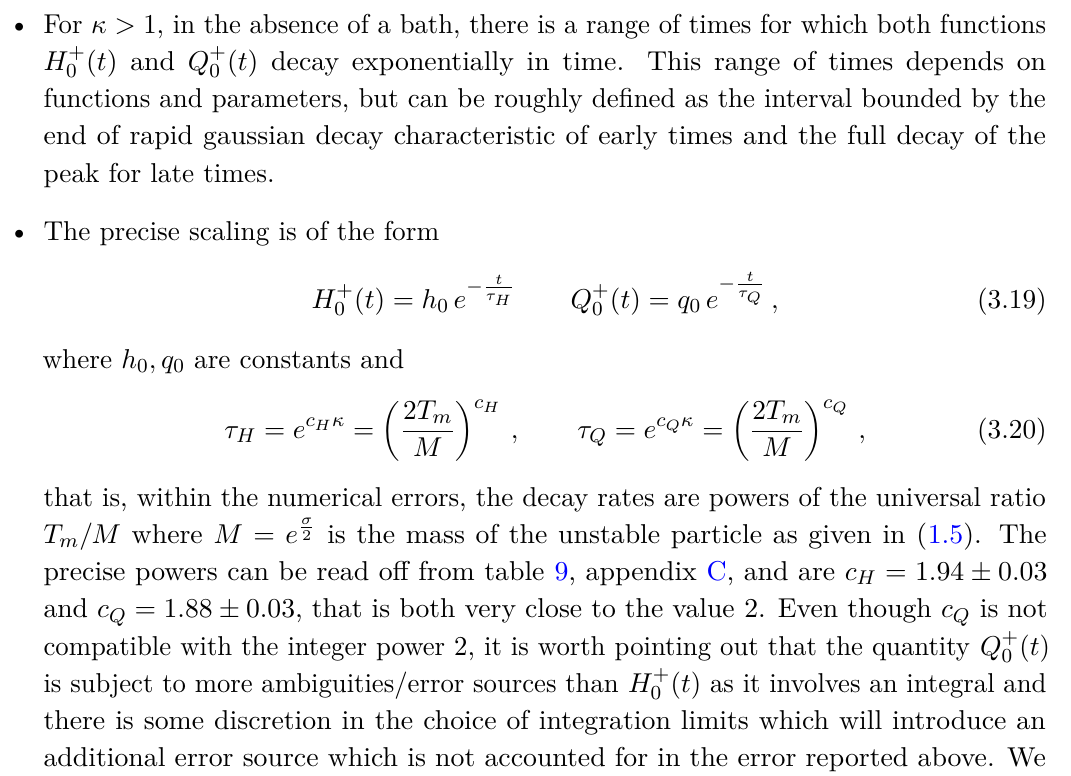
Figure 7 . The logarithm of functions H + different values of κ in the legends. In the intermediate times region all functions scale linearly with parameters that are summarised in table 7, appendix